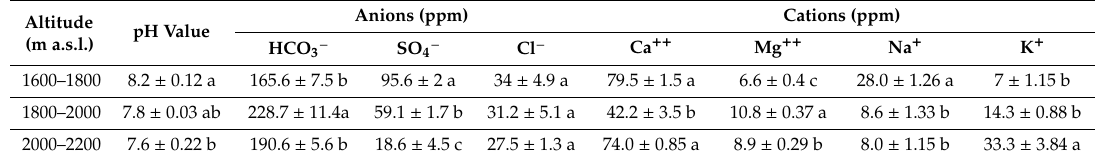
Table 1. Chemical analysis of soil samples collected from Saint Katherine protectorate (SKP) mountains at different altitudes (1600 – 1800, 1800 – 2000, and 2000 – 2200 m a.s.l.). Data are means of three replications ± SE.